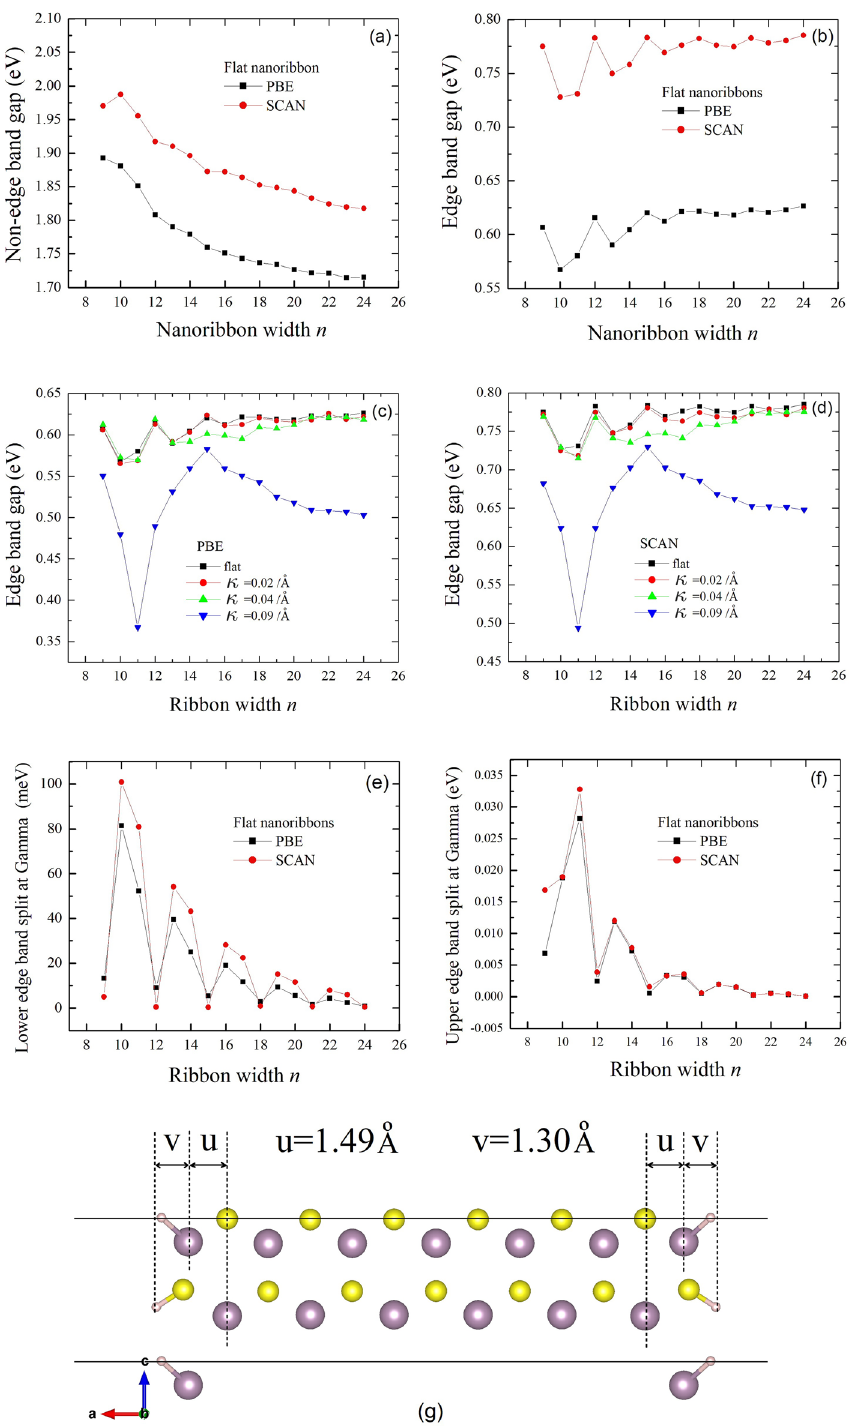
Figure 3. The gaps of nanoribbons A n MoS 2 with n from 9 to 24, obtained with the PBE and SCAN functionals, as the function of ribbon width and the relaxed atomic structure of the flat A13MoS 2 nanoribbon. The non-edge band gap (NEG) is in ( a ), the edge band gaps (EG) in ( b ), ( c ) and ( d ), the non-degenerate splits of edge bands (cid:31) E V (lower edge band split) in ( e ) and (cid:31) E C (upper edge band split) in ( f ). In ( c ) and ( d ), the curves under different bending curvatures are shown. NEG approximately shows a monotonic decrease trend with n , while EG shows an oscillating feature with a period (cid:31) n = 3 . (cid:31) E C = E C2 − E C1 , defined as the energy difference between C2 and C1 at the Ŵ point (see Fig. 1d), and (cid:31) E V = E V1 − E V2 , the energy difference between V1 and V2 at the Ŵ point. In ( g ), the distance u, which is the horizontal (ribbon width direction, or cell-vector a direction) distance between the outmost Mo atom and the next outmost Mo atom, is approximately equal to the distance v, the horizontal distance between the outmost Mo and H